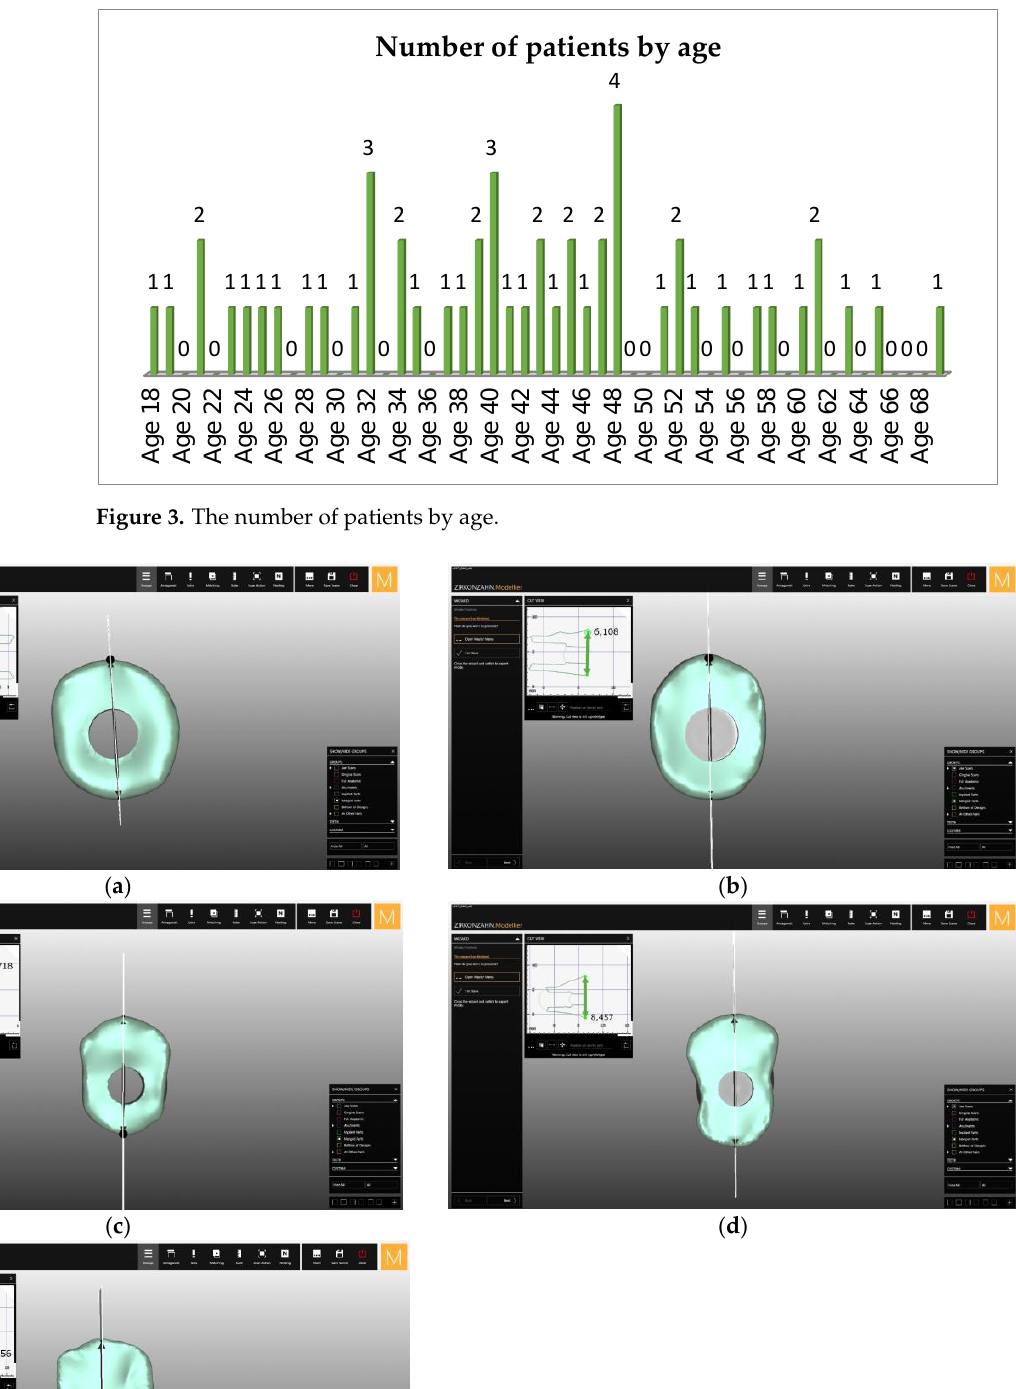
Table 1. Results of the measurements (mm) of L, C1, H, and C2 for the central incisor, lateral incisor, canine, first premolar, and first molar (mm).